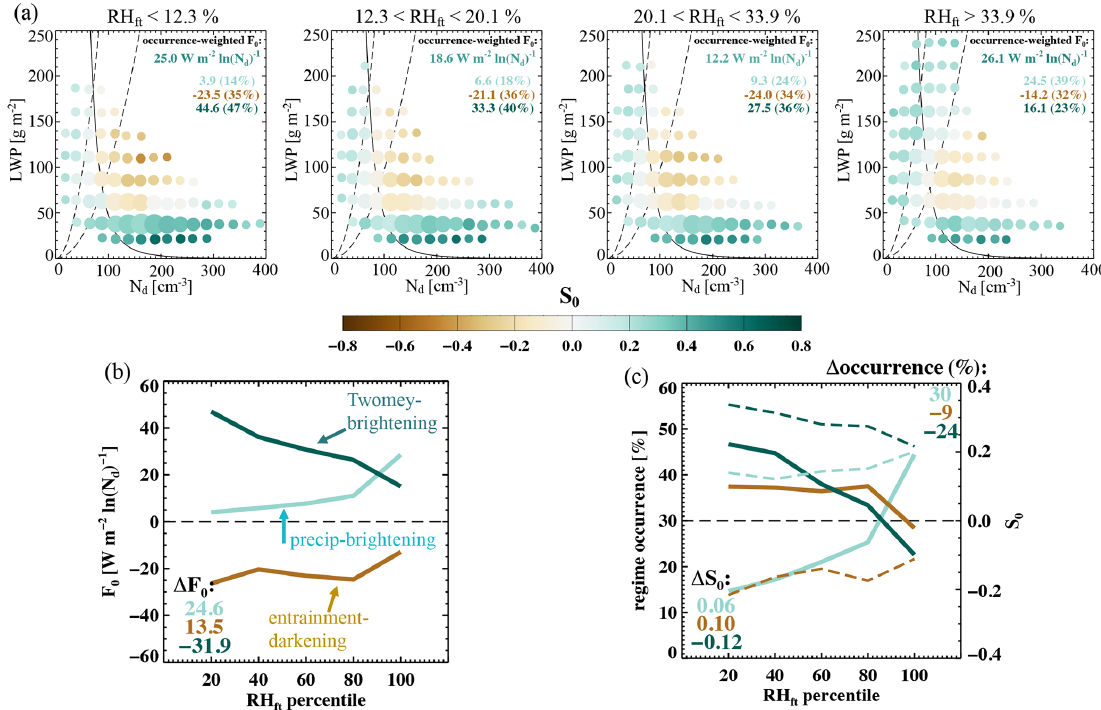
Figure 8. As in Fig. 6 but for free-tropospheric relative humidity (RH ft ).